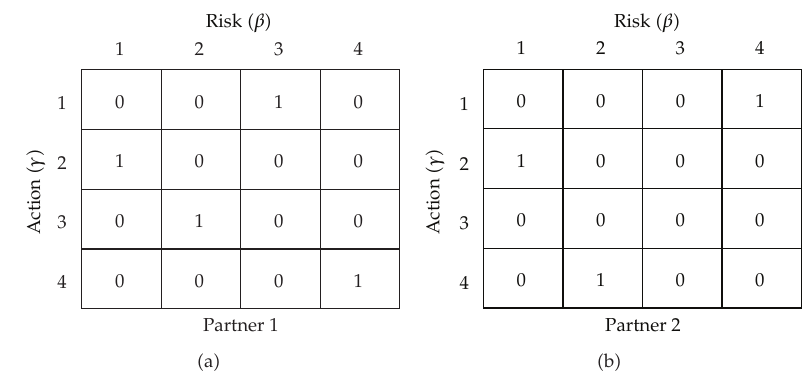
Figure 11: Definition of a discrete particle (cid:3) 2314, 2401 (cid:4) for the action combination of two partners.